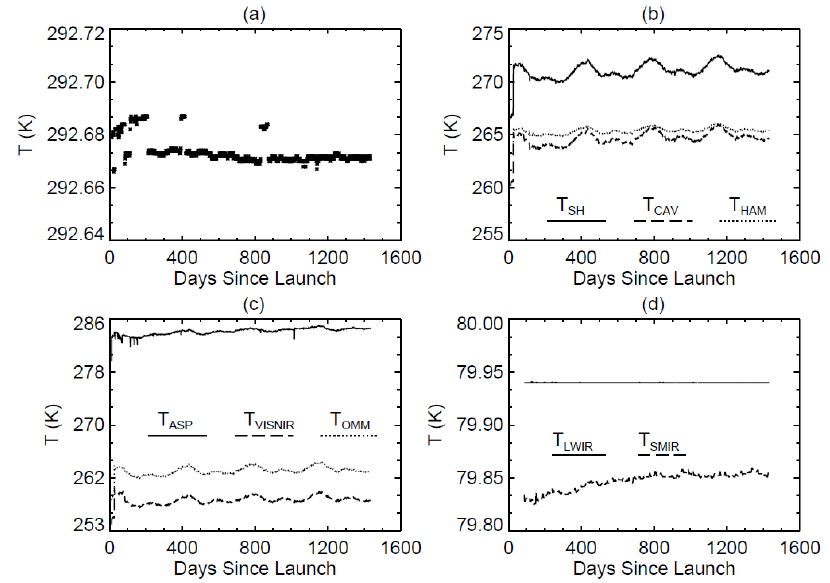
Figure 5. Daily averaged VIIRS sensor telemetry trended over the entire mission. ( a ) The trending of the BB temperature; ( b ) graph of the temperature trend for the inputs to the thermal model: HAM, scan cavity (CAV) and BB shield temperatures; ( c ) plot of the temperature trends for electronics (ASP), instrument (OMM) and VIS/NIR FPA temperature; and ( d ) the S/MWIR and LWIR FPA temperature trends.